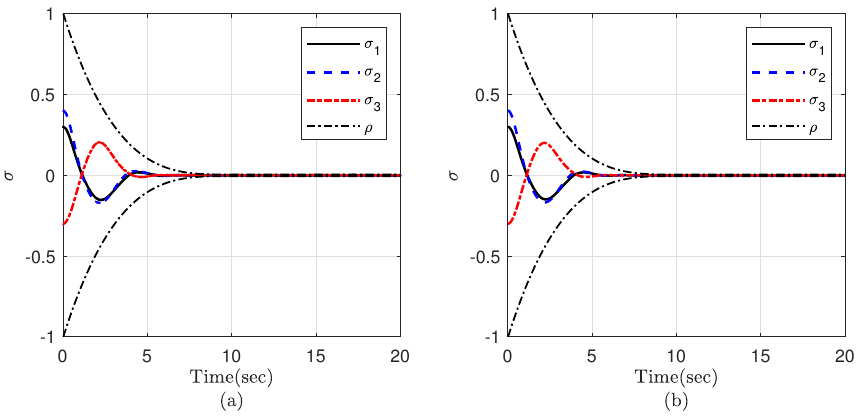
Figure 15. The attitude in Part 3: ( a ) noisy measurement, ( b ) high-frequency disturbance.